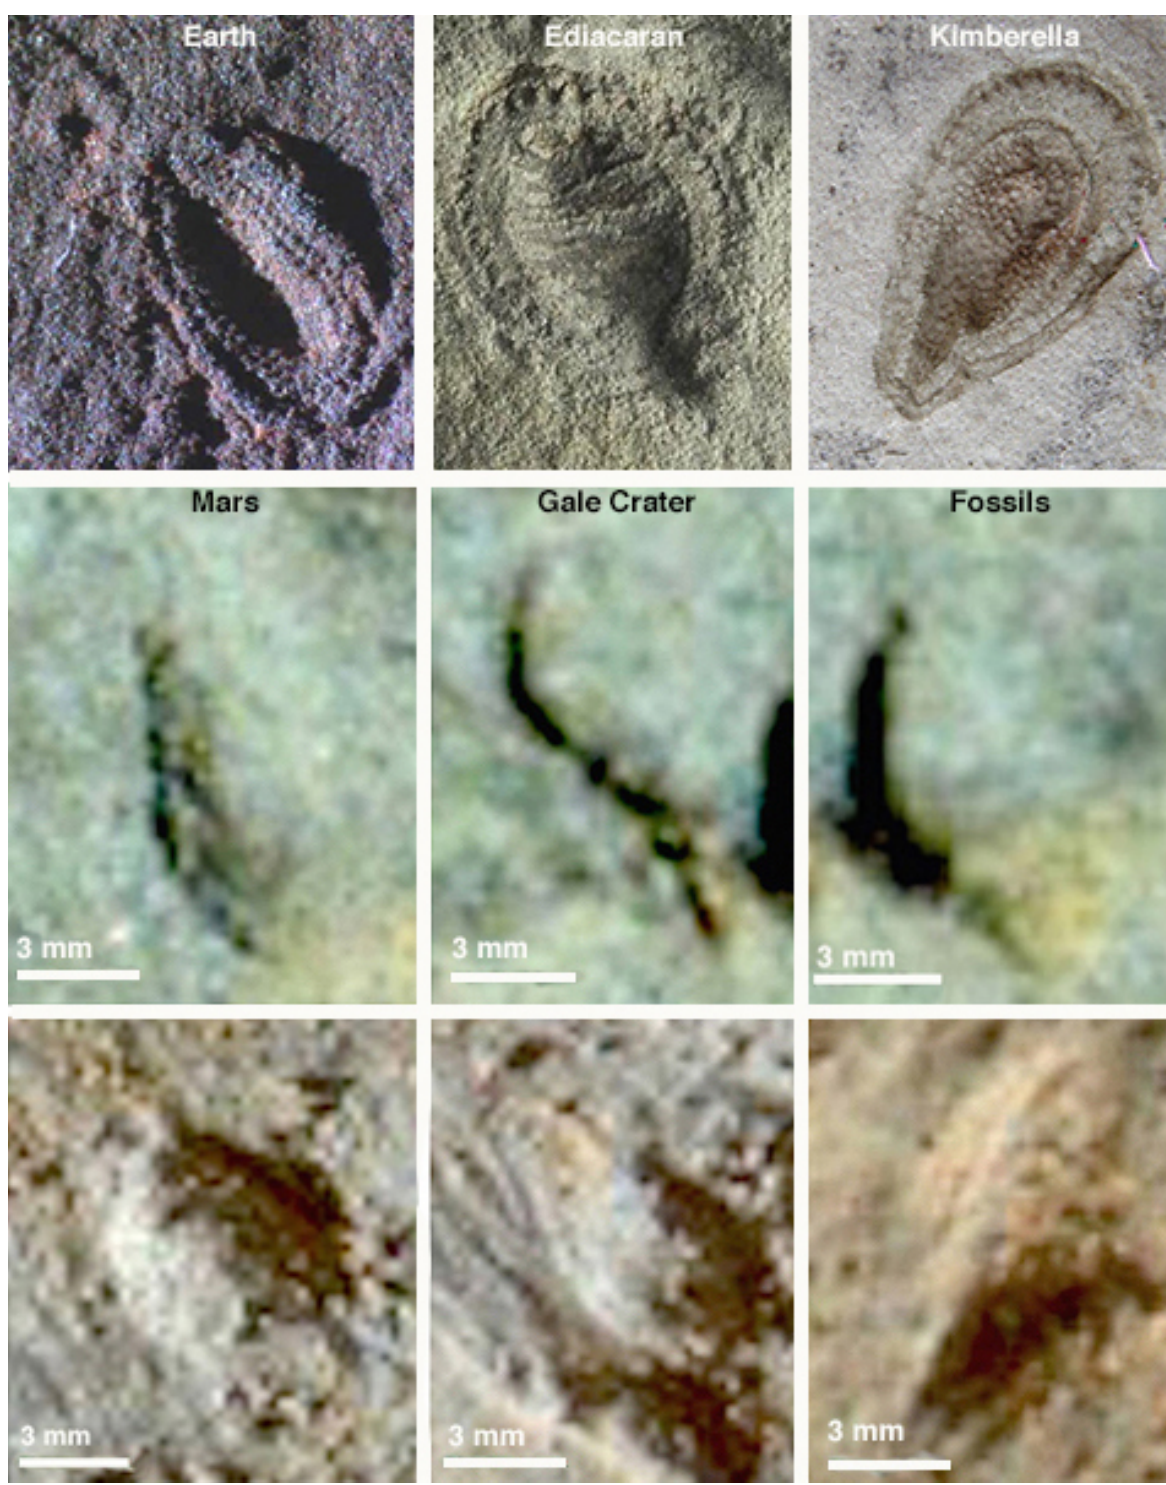
Figure 4. (First row) fossilized remains of Ediacaran Kimberella. (Bottom two rows): Specimens photographed in Gale Crater, quantitatively and statistically nearly identical to Ediacaran fossils of Kimberella. Sol 809, Sol 809, Sol 809; Sol 880, Sol 905, Sol 905. Note proboscis and "zipper-like"